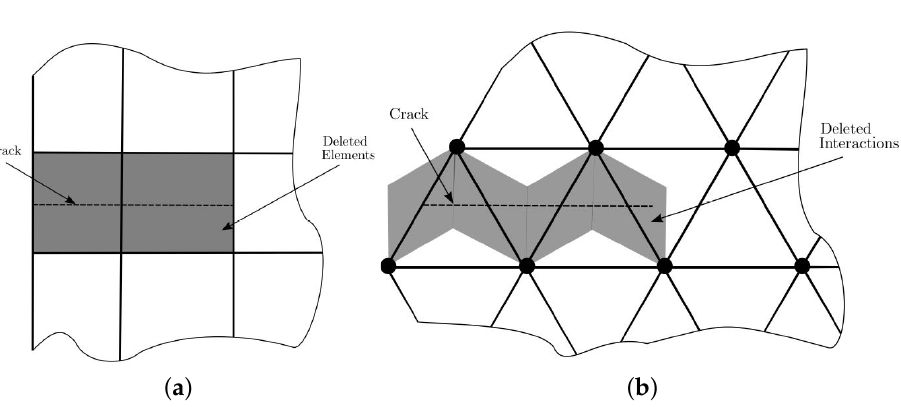
Figure 7. Representation of a crack by deleting ( a ) elements in finite element method and ( b ) interactions in discrete